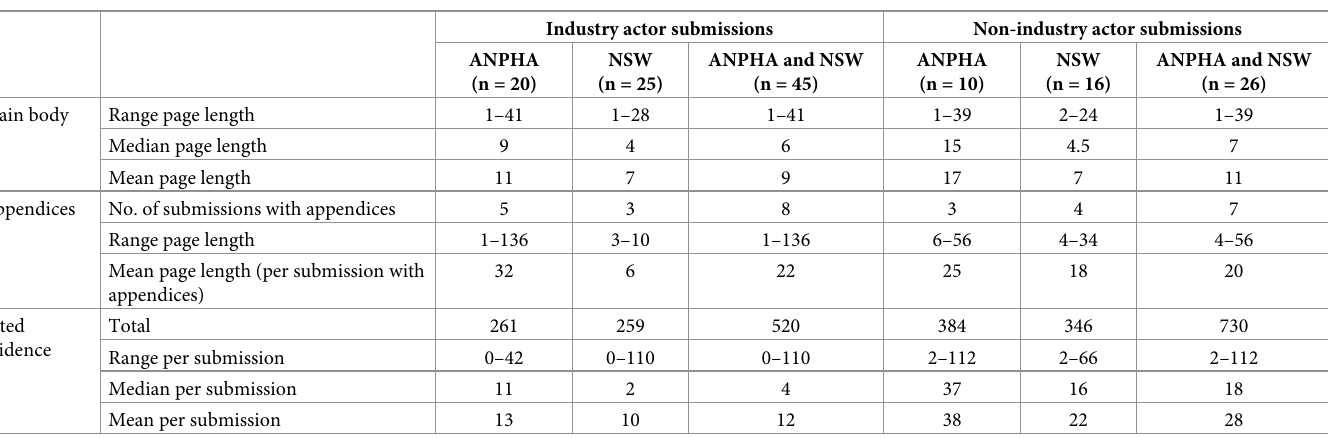
Table 2. Submission